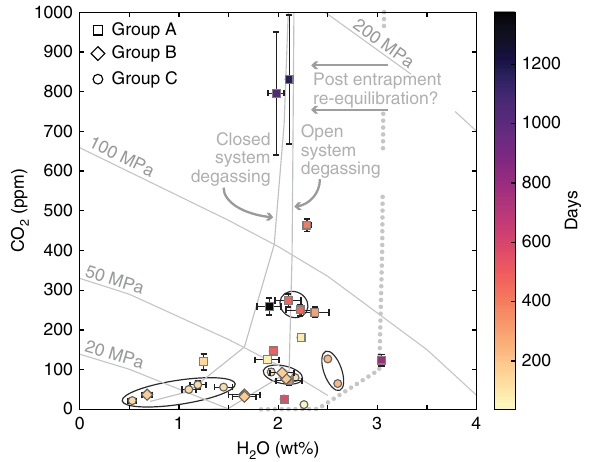
Fig. 5 Volatile contents vs. timescales. H 2 O and CO 2 contents plotted with isobars and calculated diffusion timescales (shown in colour bar). Melt inclusions from the same crystals have been grouped by a circle. Melt inclusion pressures correlate with diffusion timescales, such that deeper melt inclusions are hosted in crystals with longer timescales. Samples with system (<100 MPa) and with shorter timescales. The isobars and composition 27,28 and the solubility model from ref. 38 . The location of the degassing curve was based on the entire melt inclusion suites from refs. 27,28 ; we show an additional open system degassing curve based on 3 wt% H 2 O (dotted line). The shift to 2 wt% H 2 O suggests there may have been some post-entrapment re-equilibration at relatively shallow levels. The melt inclusion pressures may not align perfectly with the isobars because their compositions range from 48 to 56 wt% SiO 2 , highlighting the limitations of this type of plot for suites of melt inclusions. Error bars show ±2 s.d. for